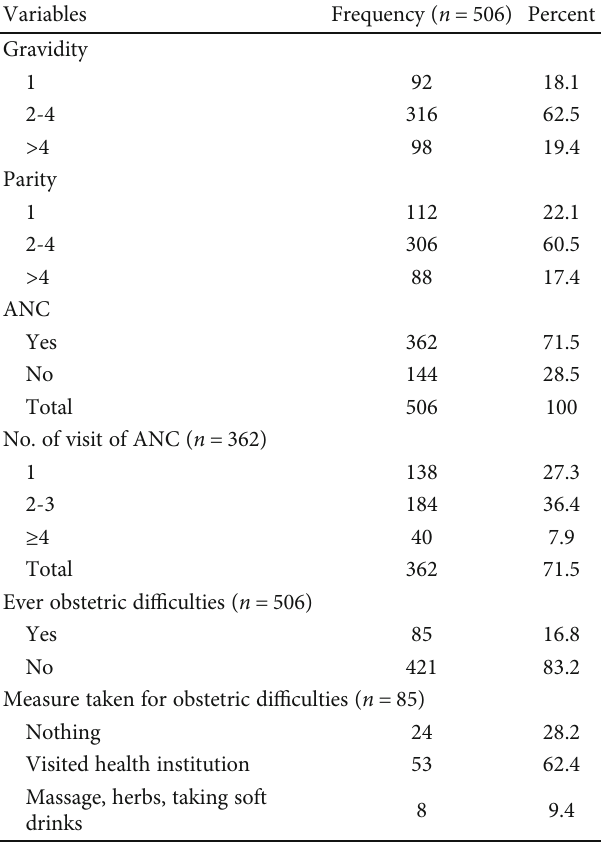
Table 2: Past obstetric characteristics of the respondents in Jimma Arjo District, Oromia, Ethiopia, 2018.